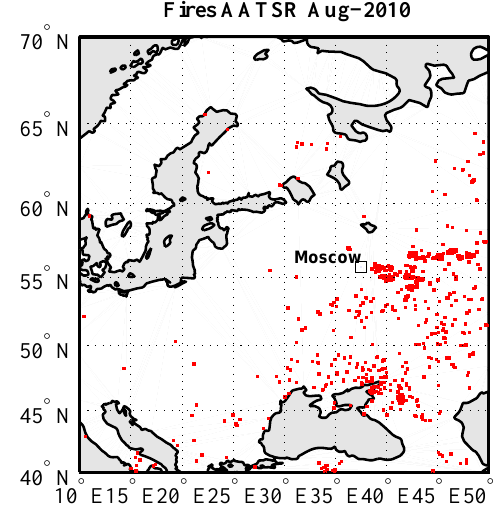
Figure 3. The occurrence of forest fires over western Russia during August 2010. Source: AATSR world fires Atlas